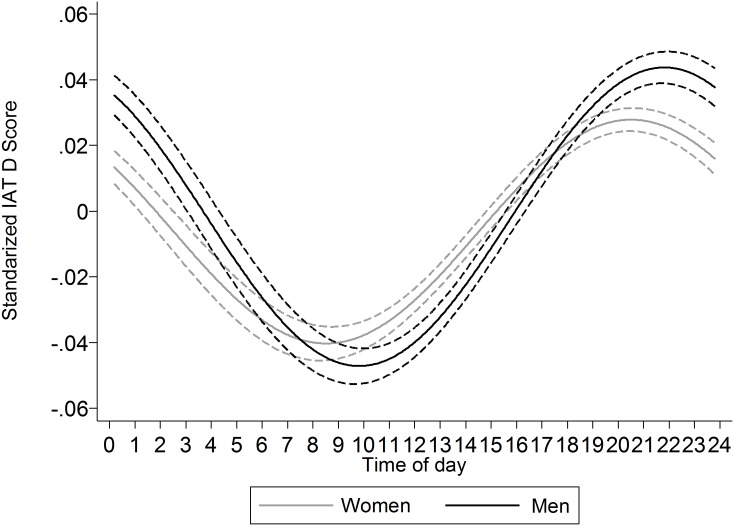
Comparison of the cosinor functions (±95% CI) for women and men.The peak of the function occurs earlier in women than in men.